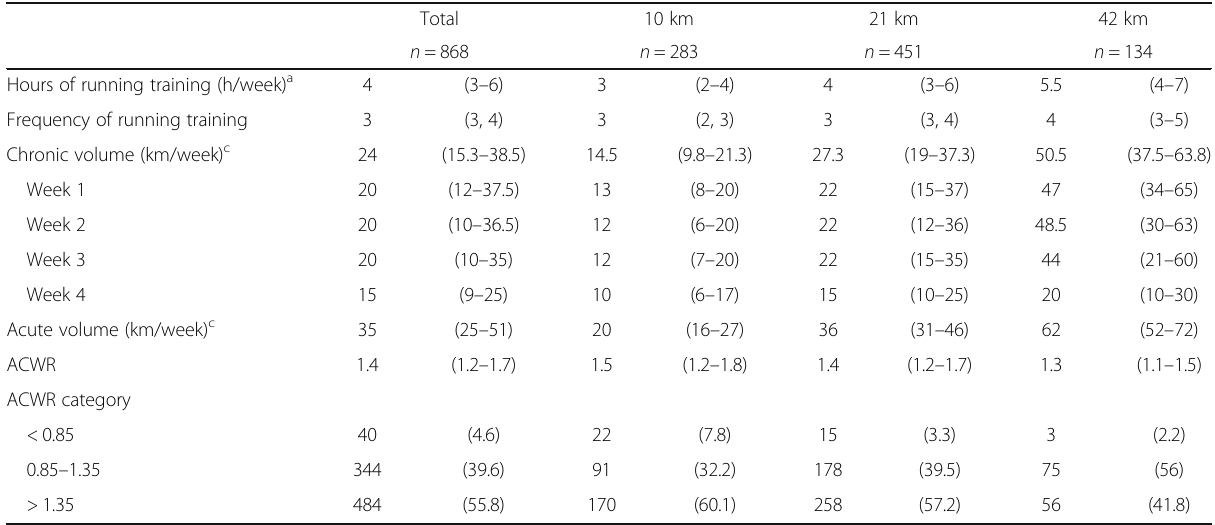
Table 2 Comparison of training characteristics and acute chronic workload ratio (ACWR) by registered distance Total 10 km